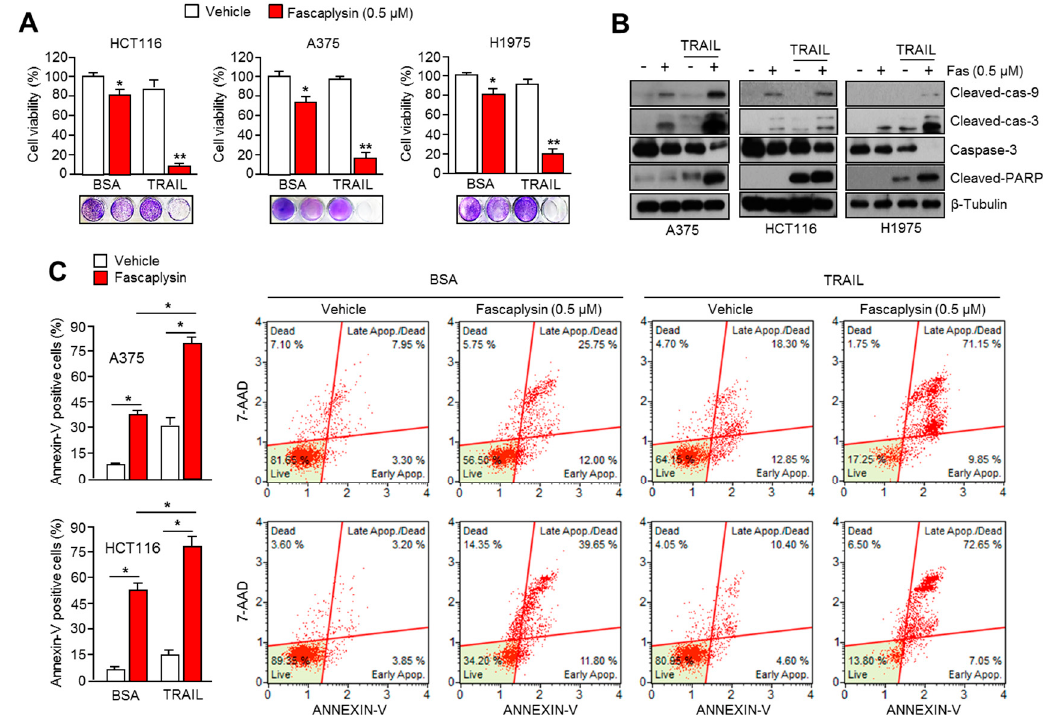
Figure 7. Fascaplysin sensitizes the anti-cancer effect of TRAIL. ( A ) Cell viability was measured in HCT116, A375, and H1975 under a combination of fascaplysin and TRAIL. Cells were incubated with 0.5 µM of fascaplysin and 20 ng/mL of TRAIL for 24 h. Values represent mean ± SD of three independent experiments performed in triplicate; * p < 0.05 and ** p < 0.01; ( B ) The cells were treated with a combination of 0.5 µM of fascaplysin and 20 ng/mL of TRAIL for 12 h, and then cleaved-caspase-9, -3, and PARP were determined by Western blotting; ( C ) A375 and HCT116 cells were incubated with a combination of 0.5 µ M of fascaplysin and 20 ng/mL of TRAIL for 24 h. After annexin-V staining, the population of cells was determined by FACS analysis. Values represent mean ± SD of three independent experiments was performed in triplicate; * p < 0.05.